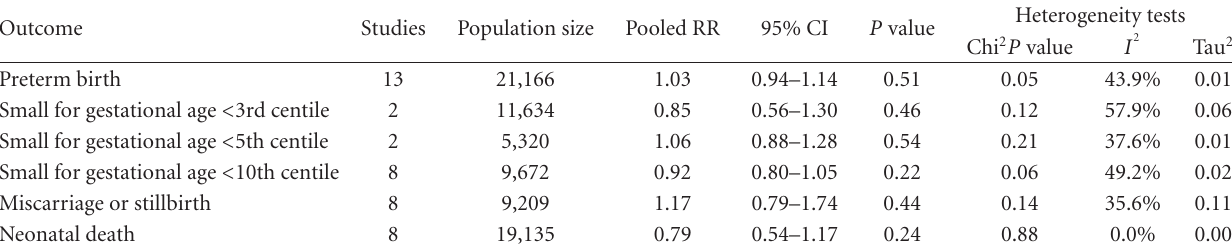
Table 2: Fetal outcomes meta-analysis and heterogeneity results. Comparison: antioxidants versus placebo.